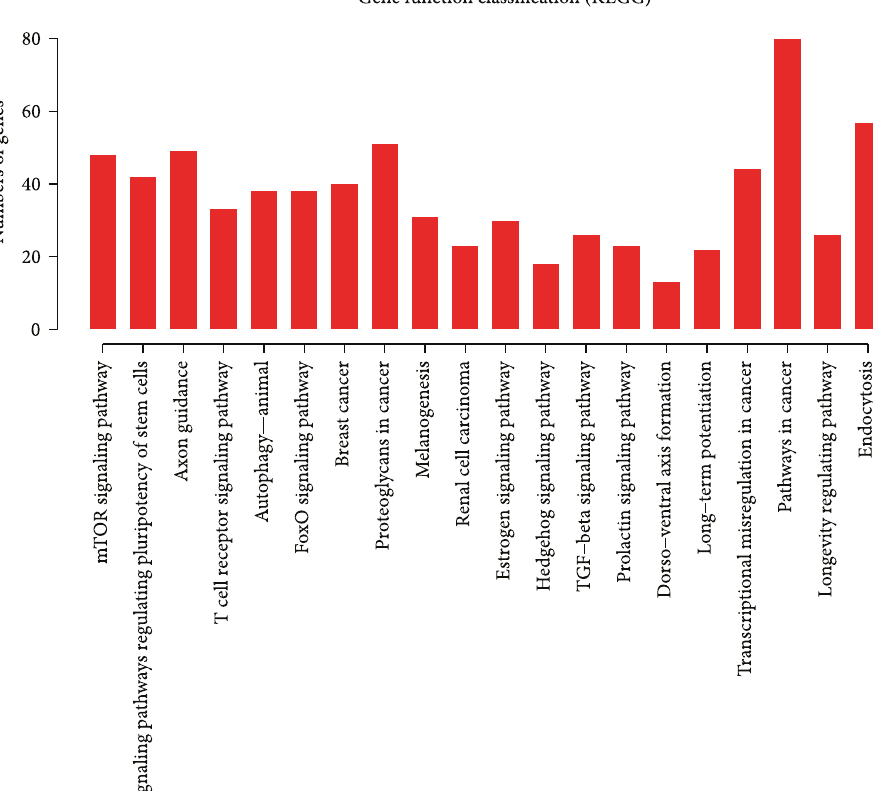
Figure 6: Twenty most signi fi cant related pathways, as determined by KEGG analysis. The ordinate indicates the number of predicted genes enriched in individual